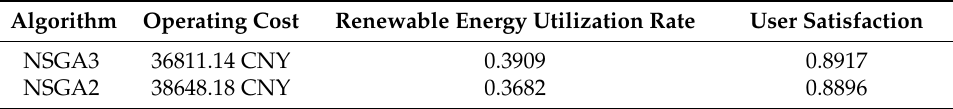
Table 3. Compromise optimal solution comparisons of different